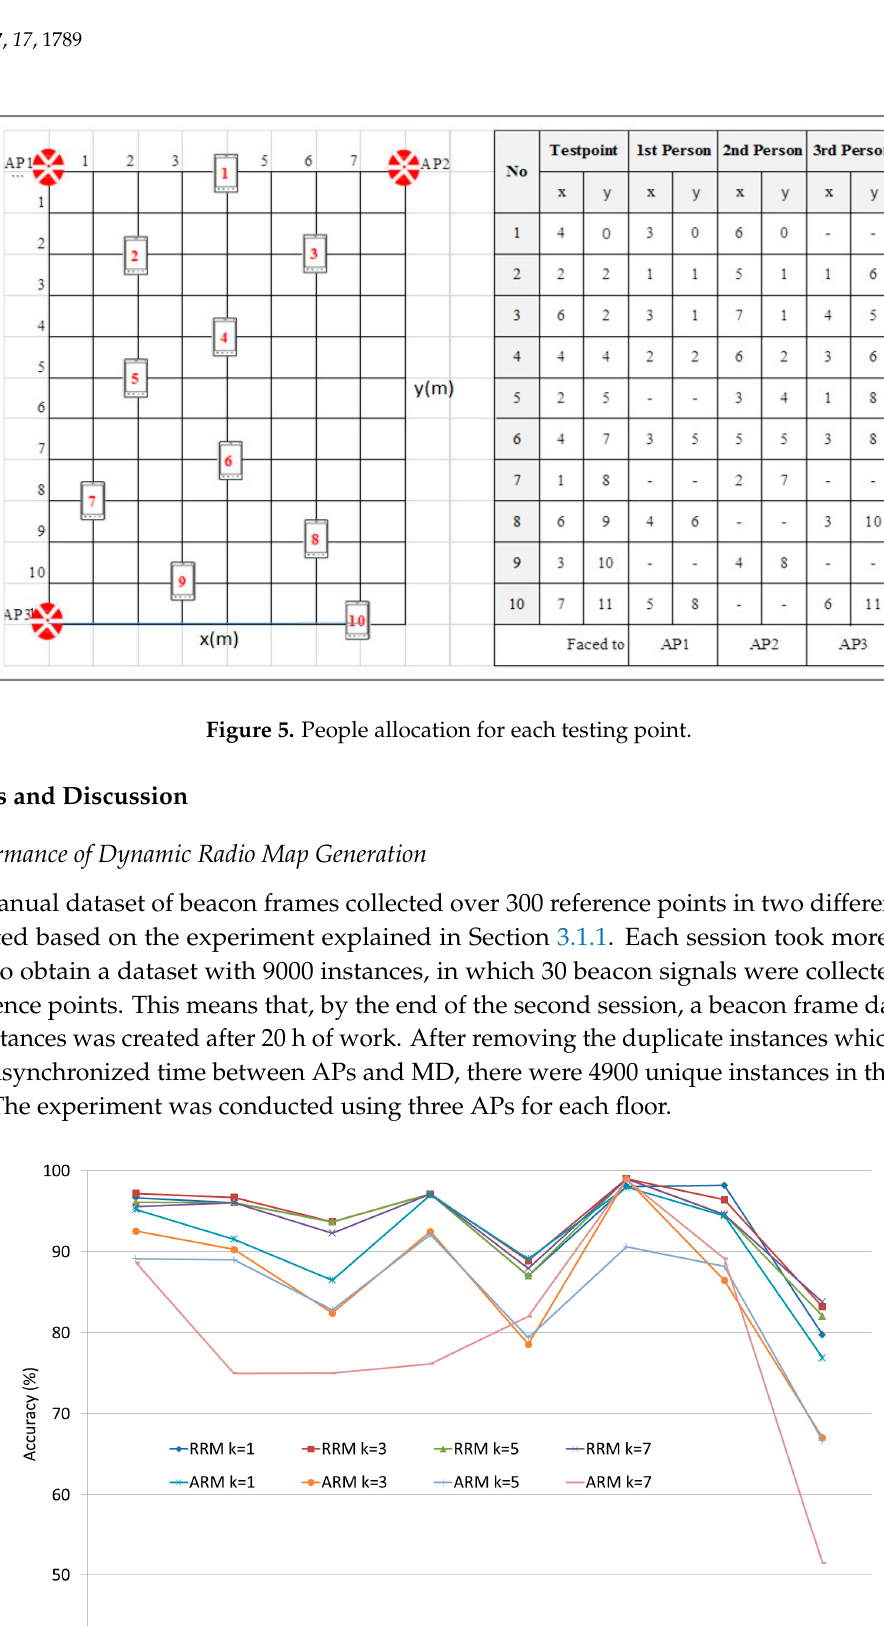
Figure 7. The accuracy of IPS when using ANN in each room. The average accuracy of IPS when using KNN and ANN can be seen in Figures 8 and 9. The obtained results showed that KNN could achieve more accurate positioning results than ANN. On the other hand, ANN had two weakness other than the poor performance. First, ANN is a model-based machine learning algorithm, which means that the system should retrain the network